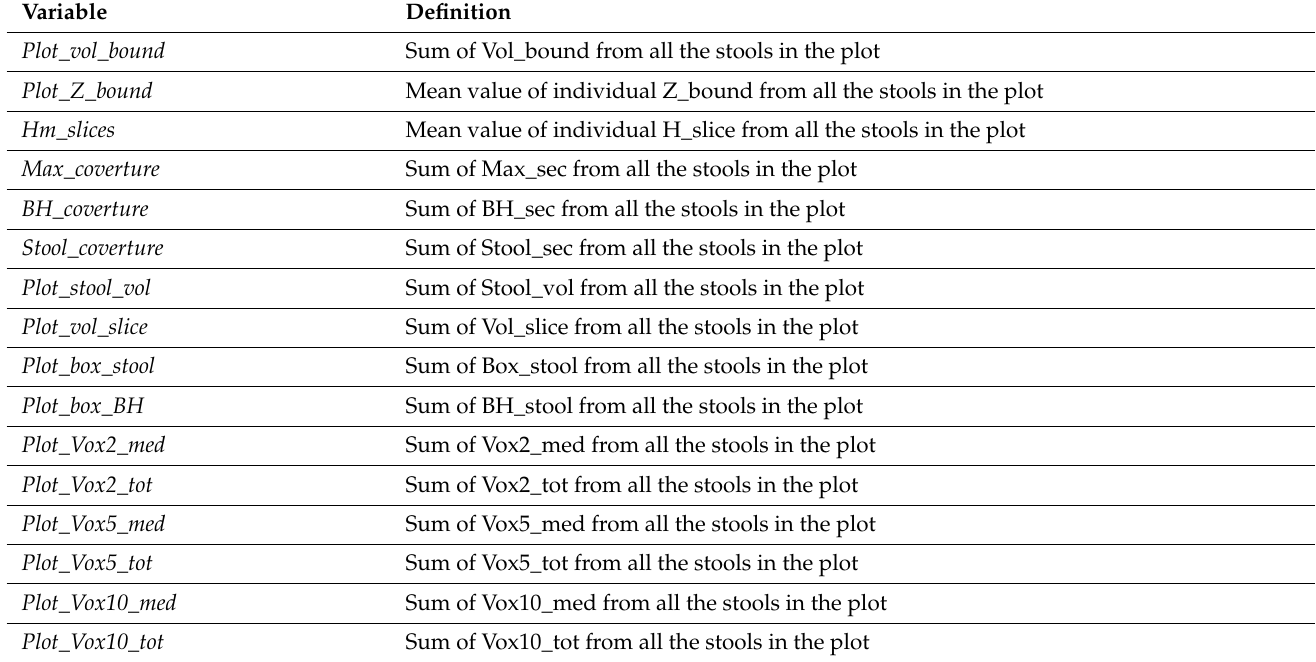
Table 2. Definition of the plot-level metrics derived from the different TLS